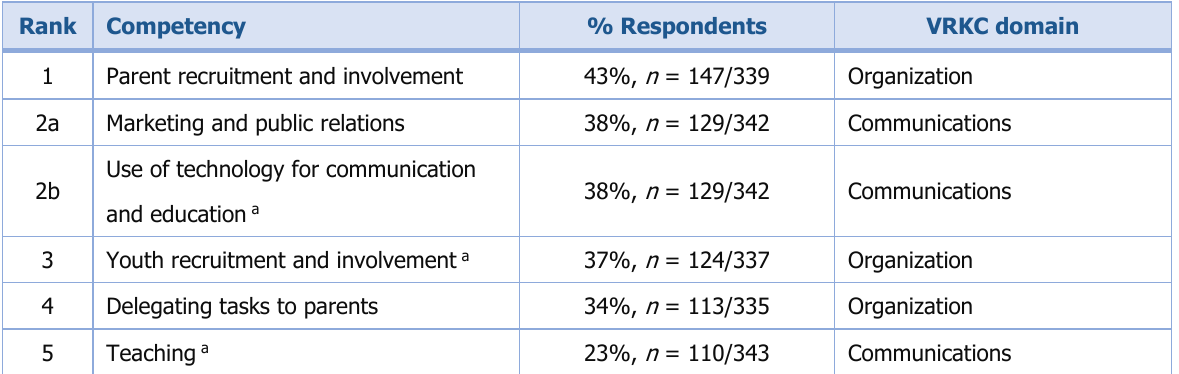
Table 4. Top Five Competencies Identified for County Program Improvement